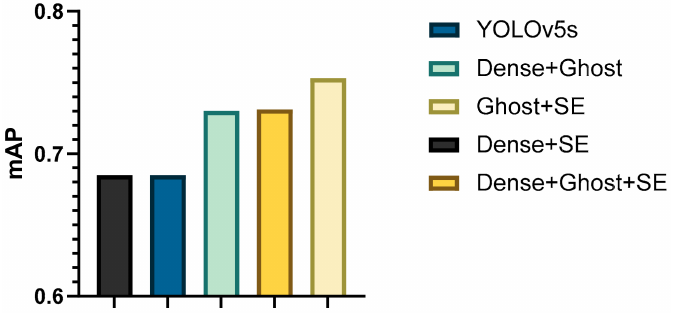
Figure 18. Comprehensive improvement of mAP